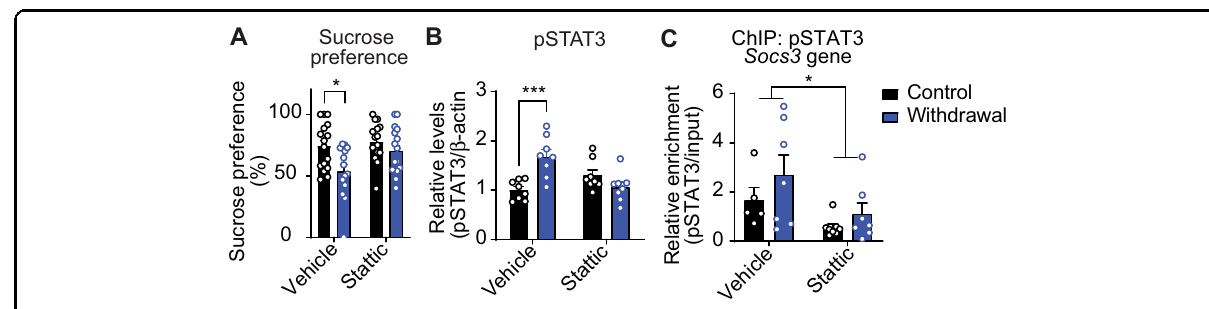
Fig. 4 Treatment with a STAT3 inhibitor during withdrawal decreases anhedonia as measured by the sucrose preference test. Rats were fed control or ethanol liquid diet for 15 days followed by withdrawal for 24 h. Stattic (50; mg/kg, i.p.) or vehicle was administered 2 h prior to testing anhedonia. Hippocampus was dissected immediately after behavioral testing and analyzed for phosphorylated STAT3 (pSTAT3) by western blot and enrichment of pSTAT3 at the Socs3 promoter using chromatin immunoprecipitation (ChIP)-qPCR. A Sucrose preference test, n = 14 – 16. * p < 0.05 by Sidak ’ s test after two-way ANOVA (stattic, F (1, 58) = 4.46, p = 0.039; withdrawal, F (1, 58) = 8.88, p = 0.0042; interaction, F (1, 58) = 1.88, p = 0.18). B pSTAT3 protein levels, n = 8. *** p < 0.001 by Sidak ’ s test after two-way ANOVA (stattic × withdrawal interaction, F (1, 28) = 17.5, p = 0.0003). C Enrichment of pSTAT3 at Socs3 gene after ChIP-PCR, n = 5 – 8. * p < 0.05, main effect of stattic by two-way ANOVA ( F (1, 23) = 6.56, p = 0.018). Data are presented as the mean ±